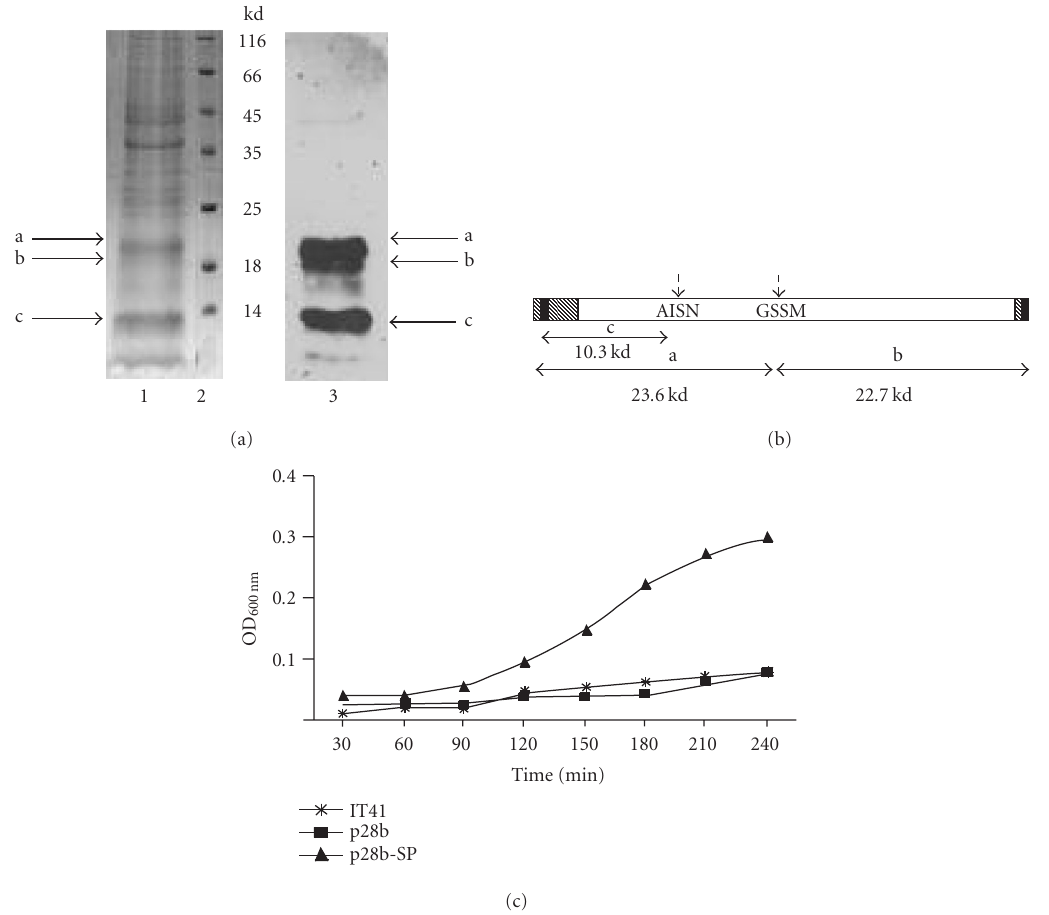
Figure 3. (a) SDS-PAGE and Western blot analysis of recombinant type I signal peptidase from P falciparum . The proteins bound to Ni 2+ -NTA-agarose matrix were separated by SDS-PAGE and stained with Coomassie brilliant blue. Lane 1 shows the various bands after this staining. The letters a, b, and c correspond to the predicted fragments in panel (b). Lane 2 is the molecular weight marker. The size of molecular weight marker is written on the right side of lane 2. The same proteins were separated by SDS-PAGE and transferred to nitrocellulose membrane using standard protocols. The blot was probed with His-tag monoclonal antibodies and developed as described in materials and methods. Lane 3 shows that the same bands a, b, and c are reacting with the anti-His antibodies. (b) Size of the predicted degradation products of type I signal peptidase of P falciparum cloned in pET28b. The clear area in the bar demonstrates the sequence of type I signal peptidase, area with vertical bars represents the amino acids of the vectors, and shaded area at the two ends is the His tag. The probable cleavage sites are shown by single-letter code in the box and the dashed vertical arrows indicate the site of cleavage. The horizontal arrows under the bar denote the size and location of the possible products a, b, and c shown in panel (a). (c) Growth curves of E coli IT41 transformants containing the appropriate plasmids. The cultures grown overnight at 30 ◦ C were diluted and incubated at 42 ◦ C; the OD 600 was monitored as a function of time. All points are the mean of at least two independent